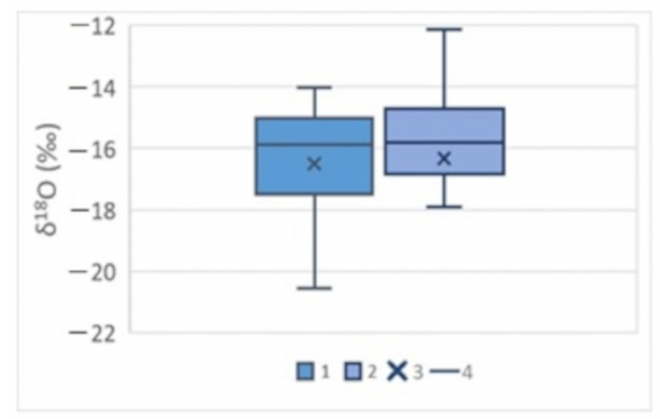
Figure 3. Box plot of glacier ice isotopic composition. 1—Glacier No.7, 2—Glacier No.9, 3—mean,